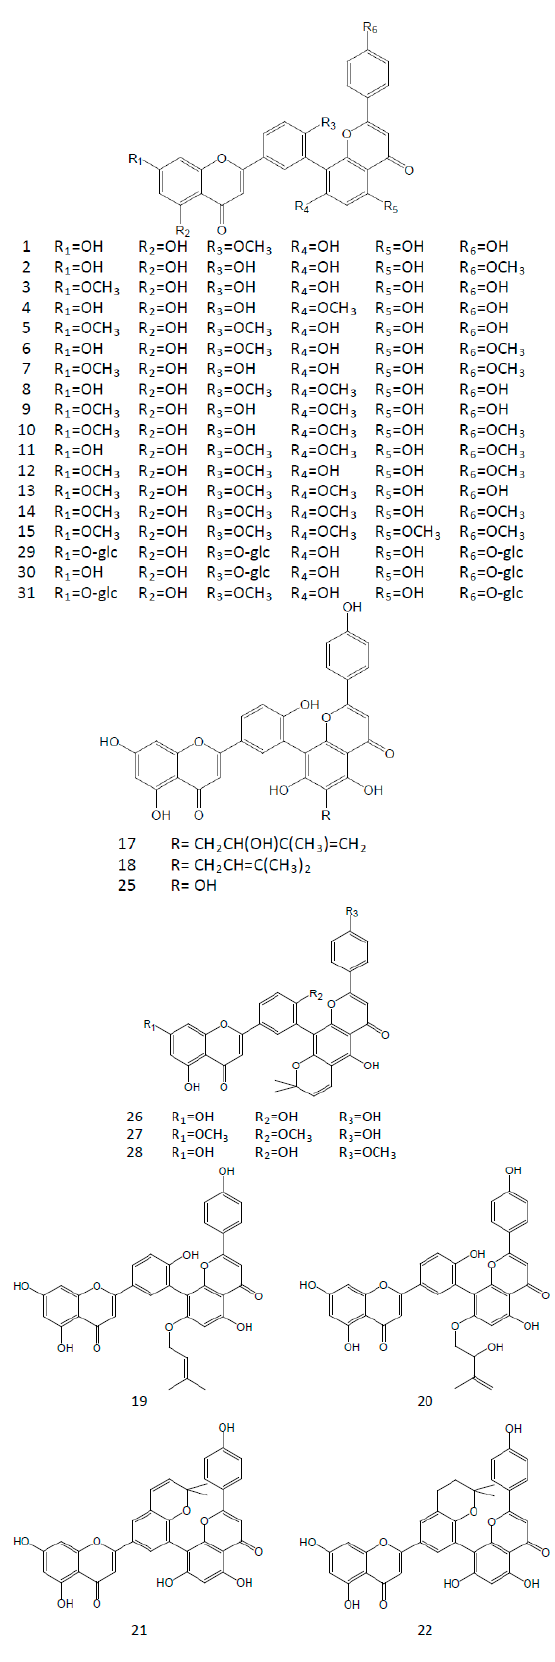
Figure 2. Chemical structures of natural derivatives of amentoflavone in plants.